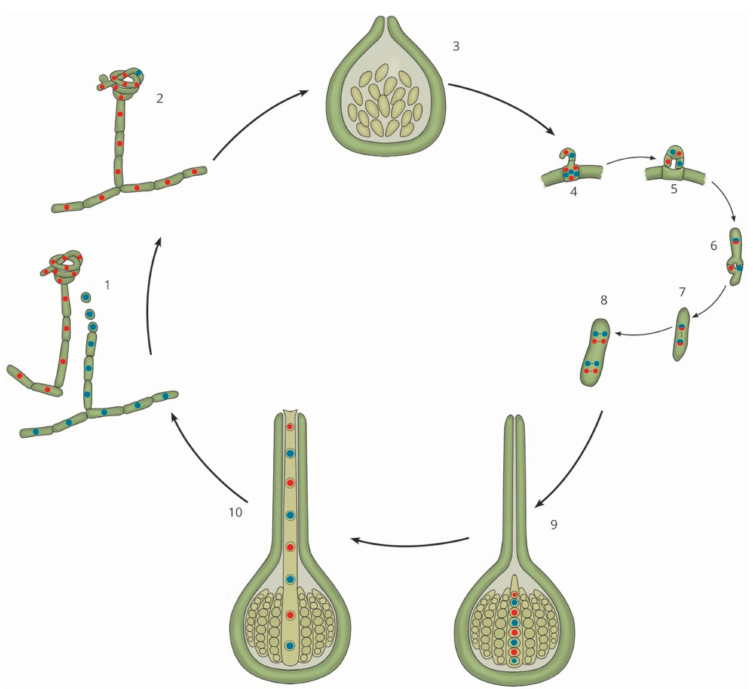
Figure 1. Generalized sexual cycle of filamentous ascomycetes. Mycelial strands (1) recognize a variety of signals before being converted into sexually competent tissue. One such signal is the recognition of a suitable mating partner. One partner produces the female structure, an ascogonium (indicated by the structure with red nuclei), while the second partner produces fertilizing spermatia (indicated by the single cells with blue nuclei). Gamete fertilization (2) occurs when the spermatia physically interact with the ascogonium. This is followed by the production of the protoascomata (3). Stages (4) to (8) occur within the immature ascomata and the developing asci. This includes the development of a crozier, nuclear migration, karyogamy, meiosis, and mitosis. This entire process culminates in a fully mature ascoma (9), which can release ascospores (10). These spores will then germinate and begin the cycle